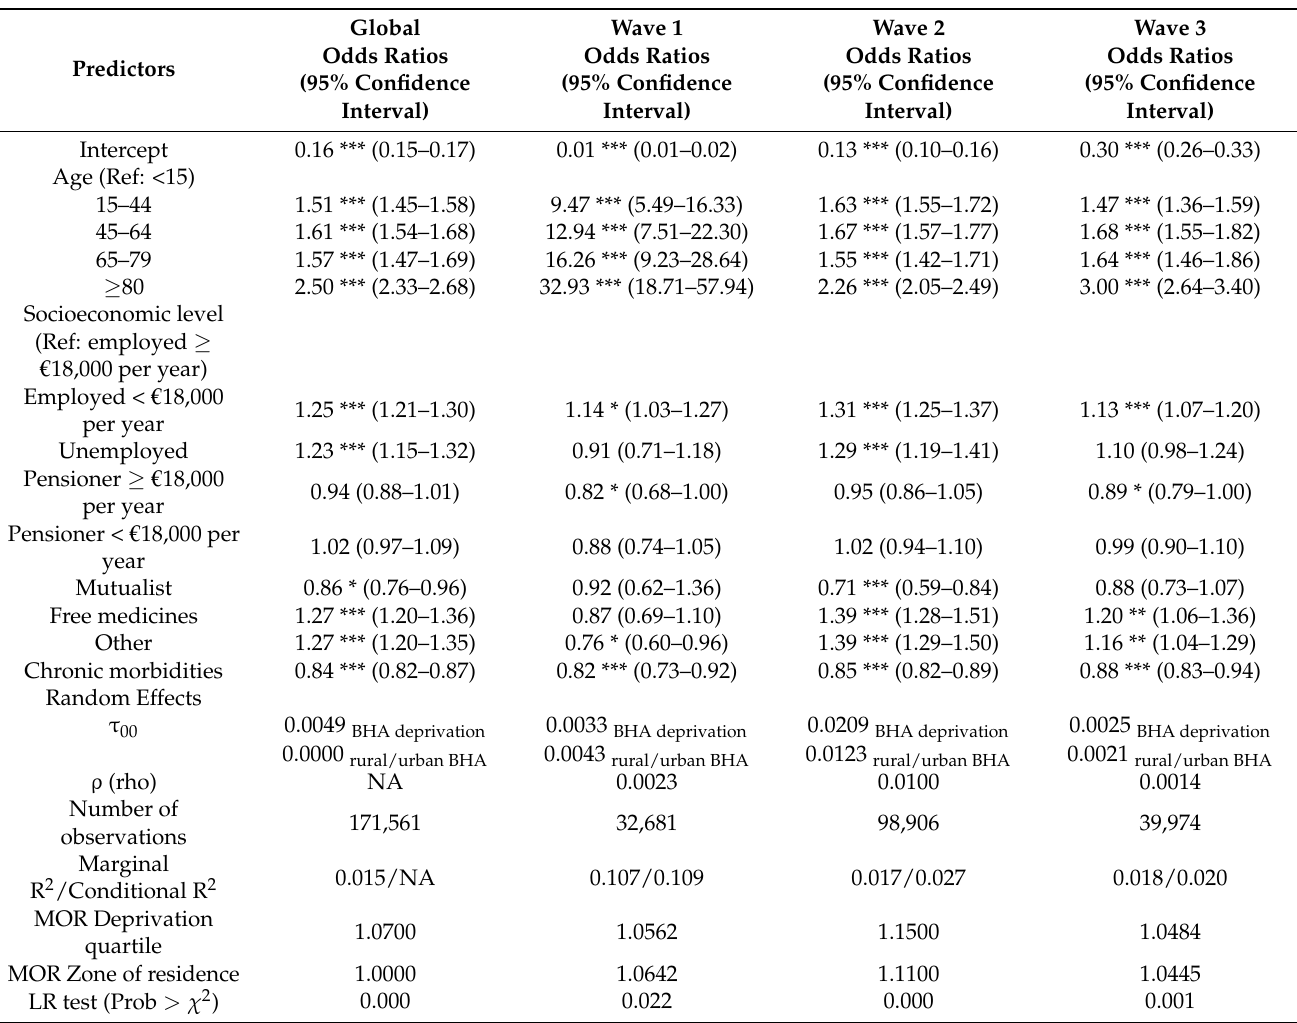
Table 3. Risk of having a COVID-19 confirmed diagnosis. Multilevel analyses in women for all the period analyzed and by